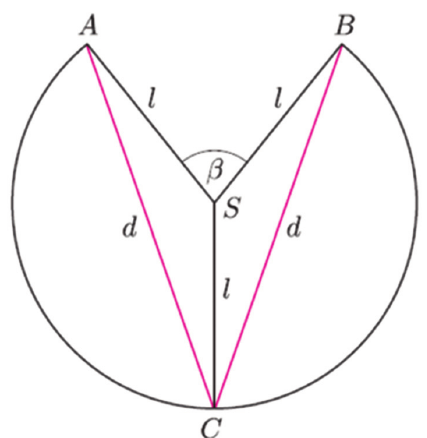
Fig. 7 . The conical circle and its diameters in 2-dimensional Euclidean space (cid:1132) 2 (Kopacz